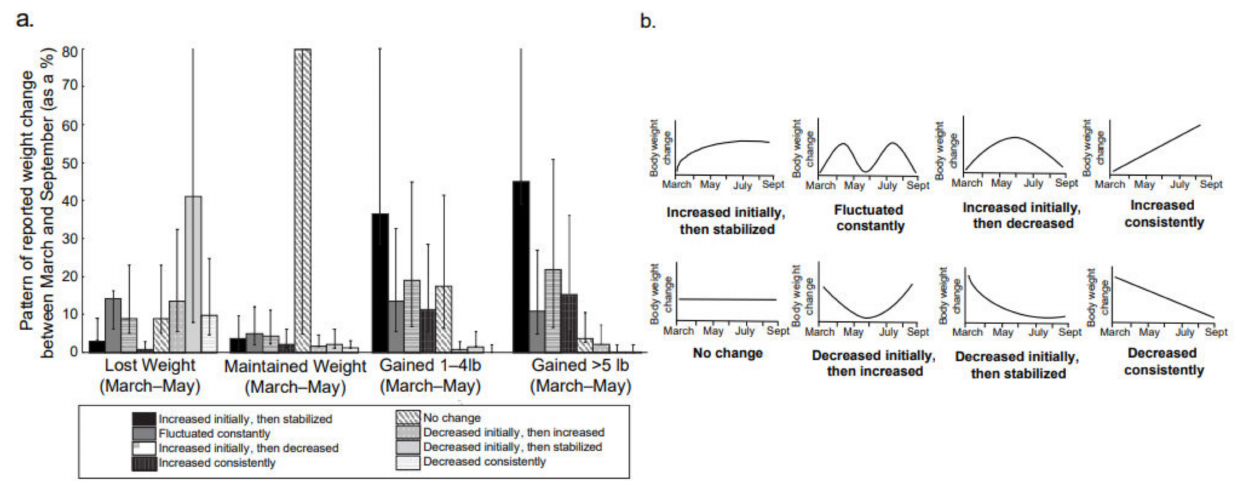
Figure 1. Pattern of Reported Weight Change Between March and September. ( a ) Percent of participants reporting patterns of body weight fluctuation across weight risk groups. ( b ) Options of patterns presented to participants to describe their weight change between March and September. Error bars represent 95% Confidence